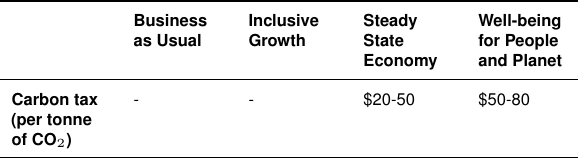
Table 8. Carbon tax in different scenarios.